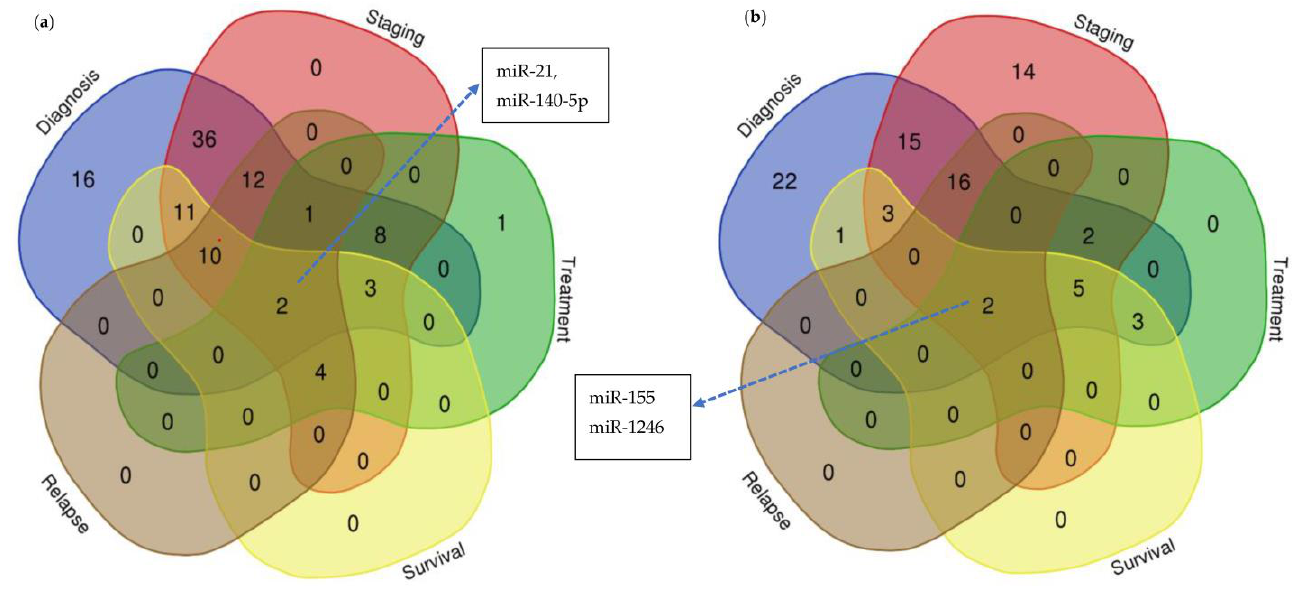
Figure 1. Number of ( a ) circulating and ( b ) exosomal and extracellular-vesicle (EV) miRNAs that play key roles in diagnosing and predicting prognosis or treatment responses among breast cancer patients. Number of ( a ) free-circulating (non exosomal) and ( b ) exosomal and extracellular-vesicle (EV) miRNAs. Numbers in the chart indicating the amount of miRNAs with the dedicated roles.